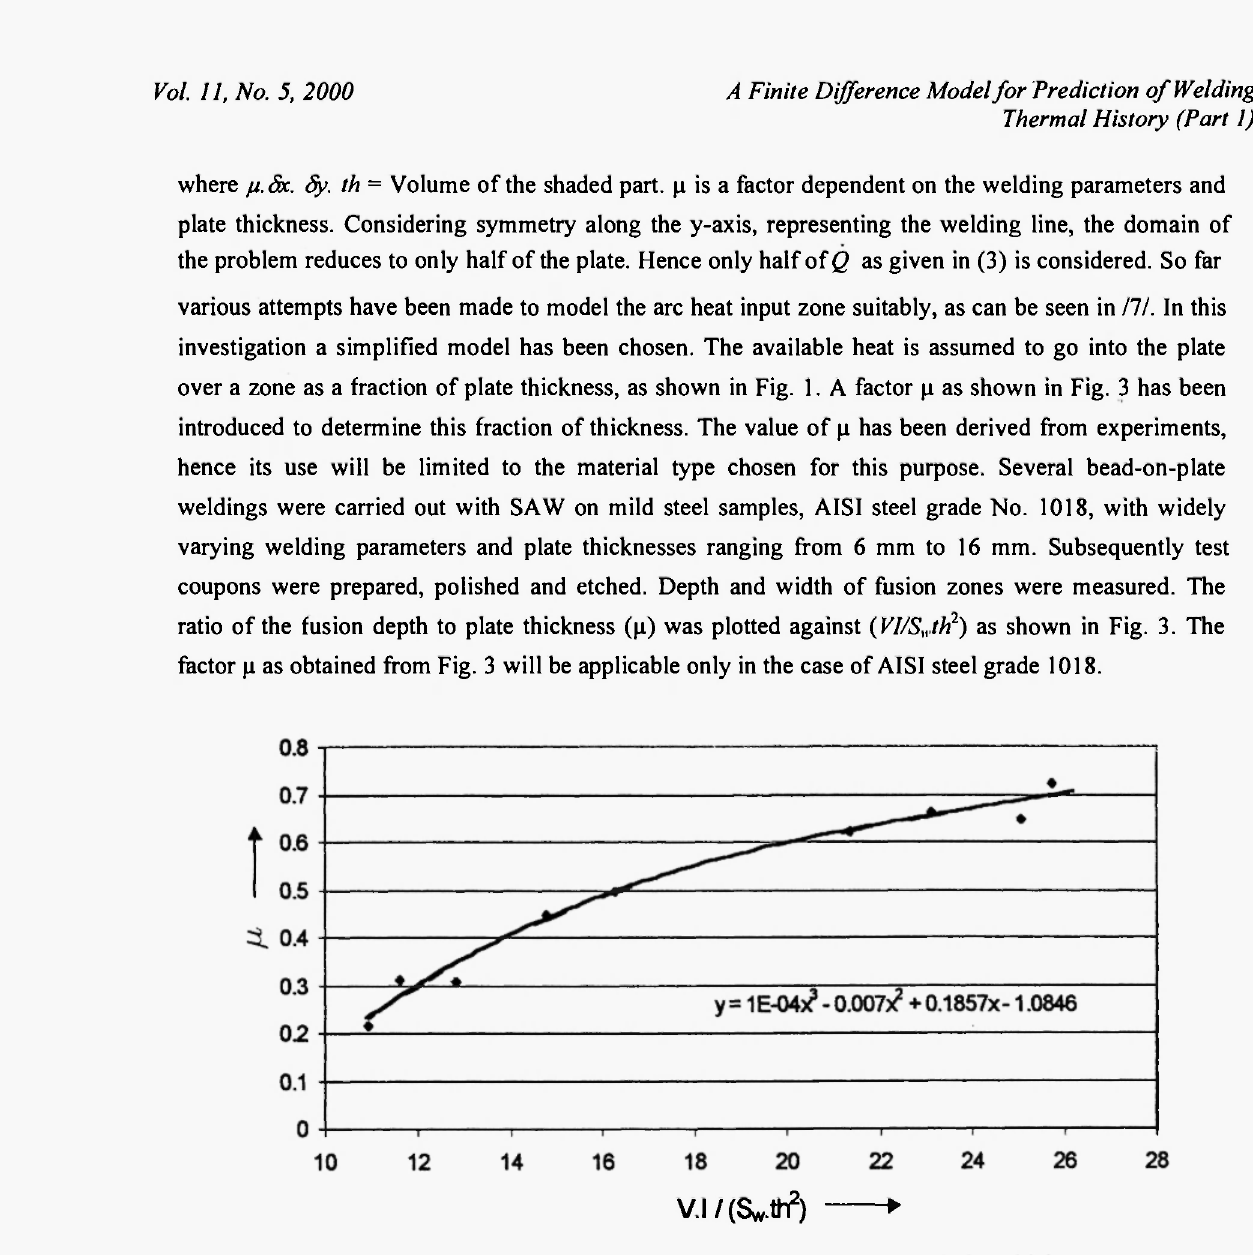
Fig. 3: Functional dependence of μ on welding parameters and plate